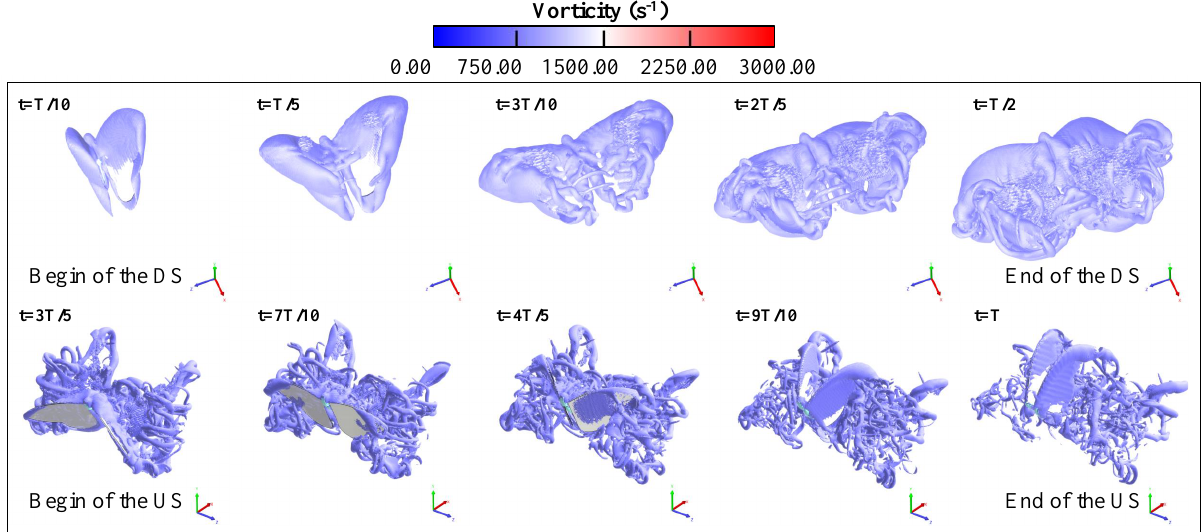
Figure 12. 3D vortex structures in the flow for the butterfly in one flapping cycle at ˆ t = 0.1, 0.2, 0.3, 0.4,0.5, 0.6, 0.7, 0.8, 0.9, and 1.0 The iso-surface of the vorticity ( ω = 7 × 10 2 s − 1